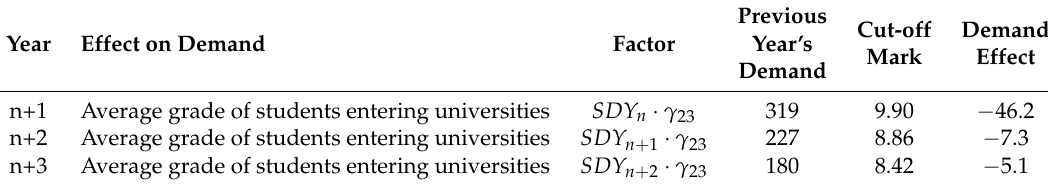
Table 7. Evolution of the effect on demand.